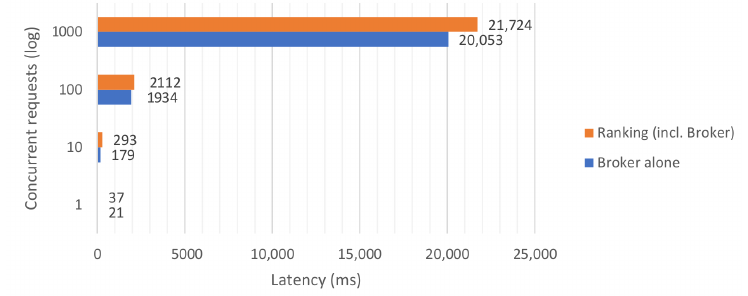
Figure 16. Ranking